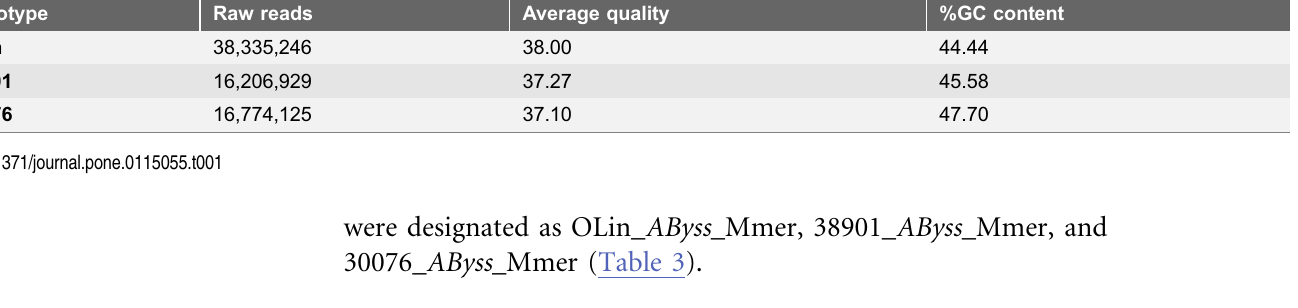
Table 1. Statistics on filtered FASTQ files using Fastx toolkit. Genotype